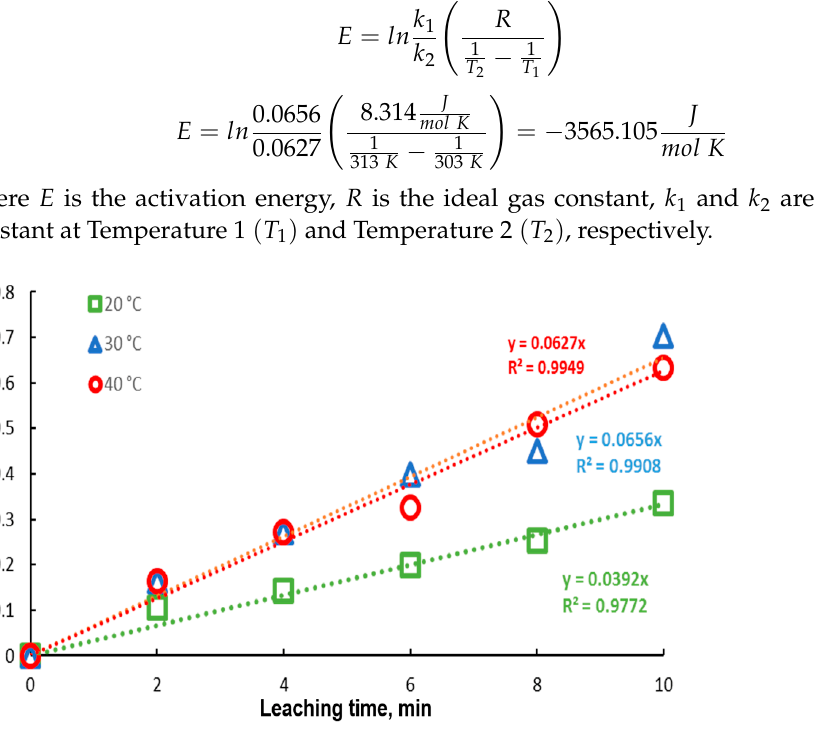
Figure 9. Fitting of the core shrinking model to data for different temperatures (20–40 ◦ C). Experimen- tal conditions: particle size: − 149/+74.1 g of mineral, 0.1 L of solution, 0.3 M Na 3 Cit, 0.6 M H 2 O 2 .